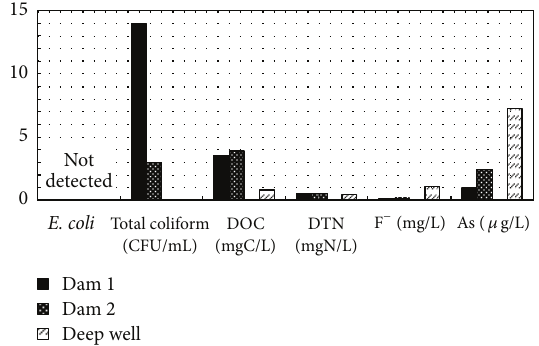
Figure 3: Comparison of water quality in dams and a deep well water at Nay Pyi Taw.